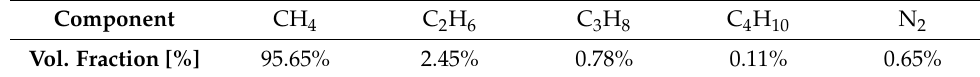
Table 3. Composition of the used natural